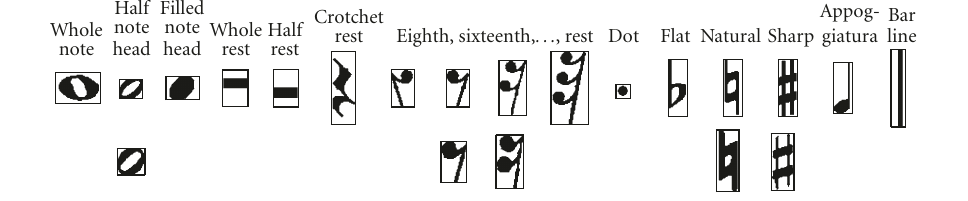
Figure 11: Reference models M k . Up to two models are used for each class k .